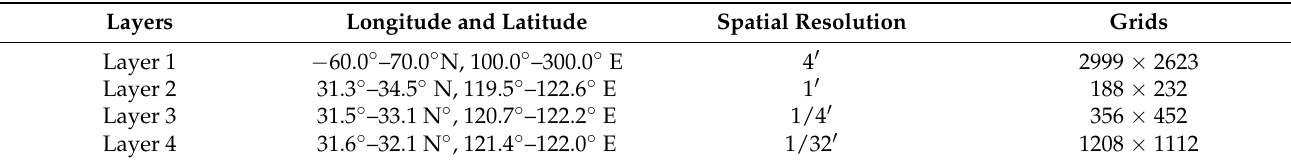
Table 2. Nested grids of numerical model.